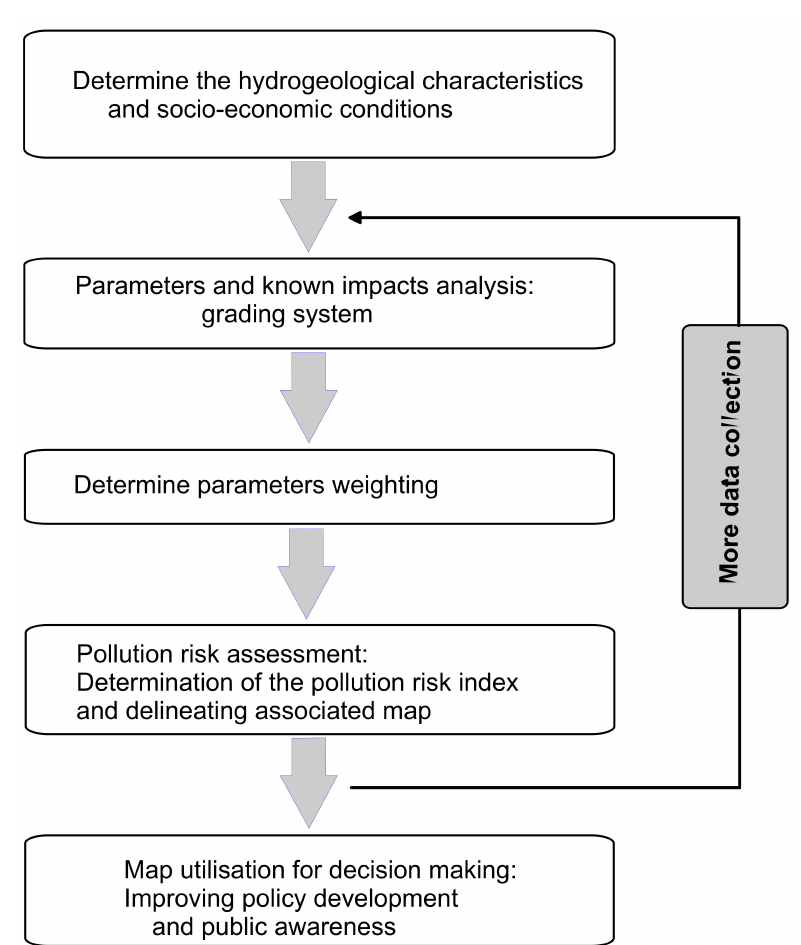
Figure 1. Flowchart showing the component of proposed approach and evaluation process for groundwater pollution risk assessment in